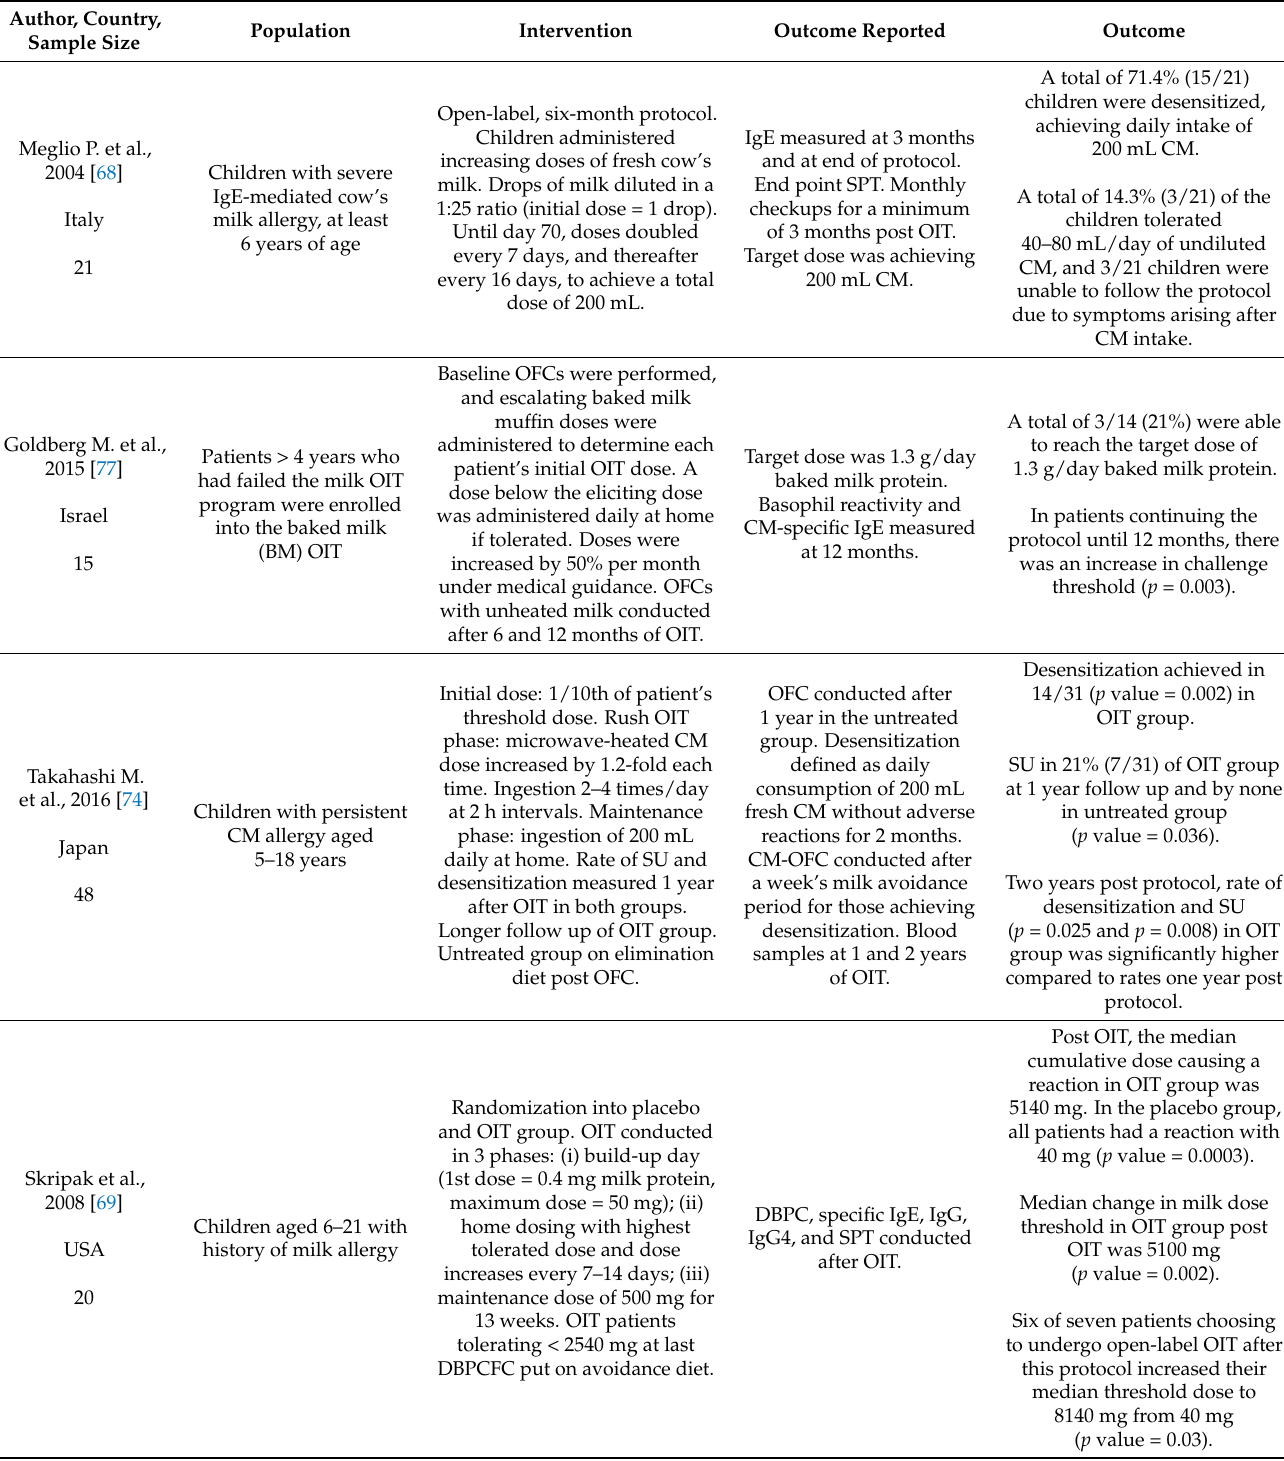
Table 4. Studies exploring oral immunotherapy in